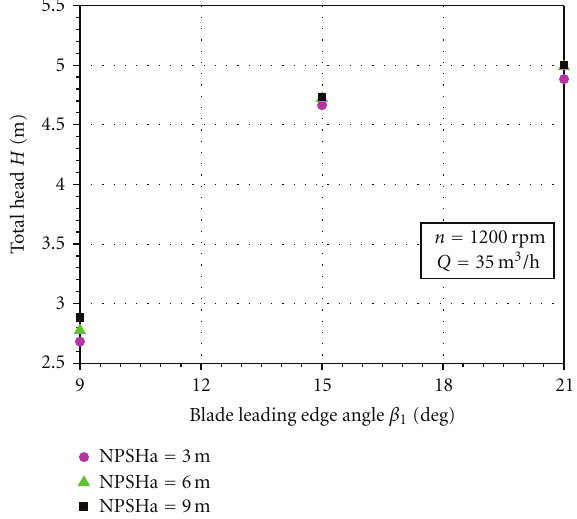
Figure 10: The change of the total head with the blade leading edge angle for three di ff erent values of the net positive suction head available.